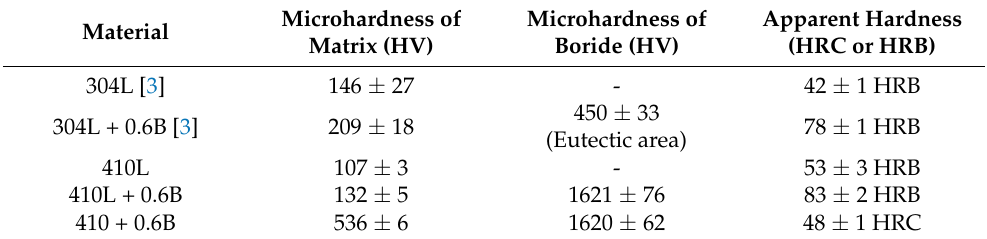
Table 3. The microhardnesses of boride and matrix and the apparent hardnesses of the five stainless steels.